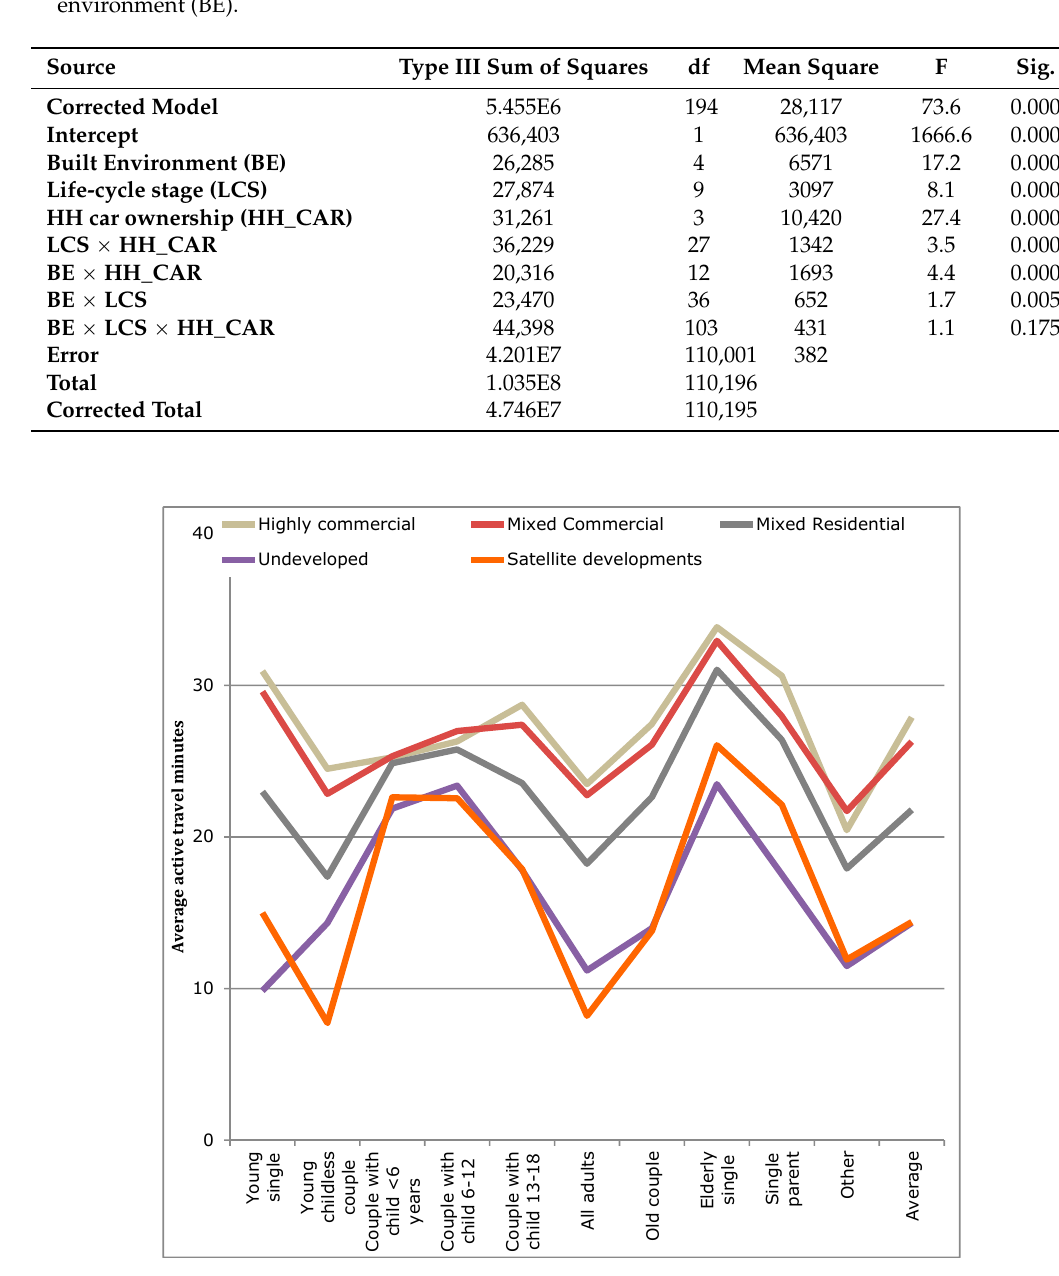
Table 3. ANOVA analysis of total household trips by car ownership, lifecycle stage (LCS), and built